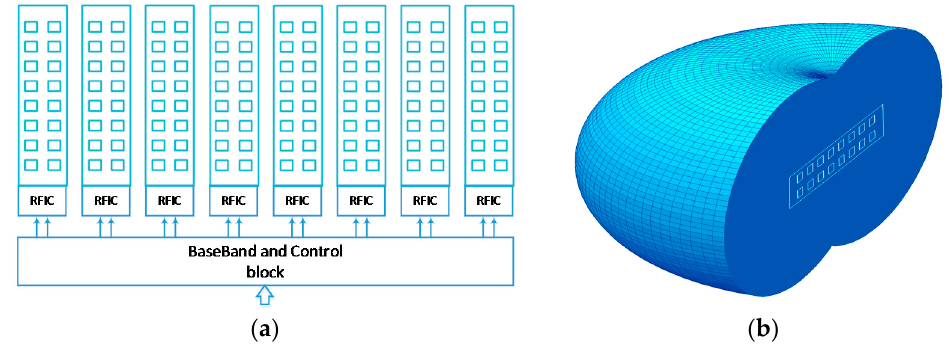
Figure 7. Highly-directional steerable mmWave antennas: ( a ) modular antenna array architecture and ( b ) lens array antenna scheme.